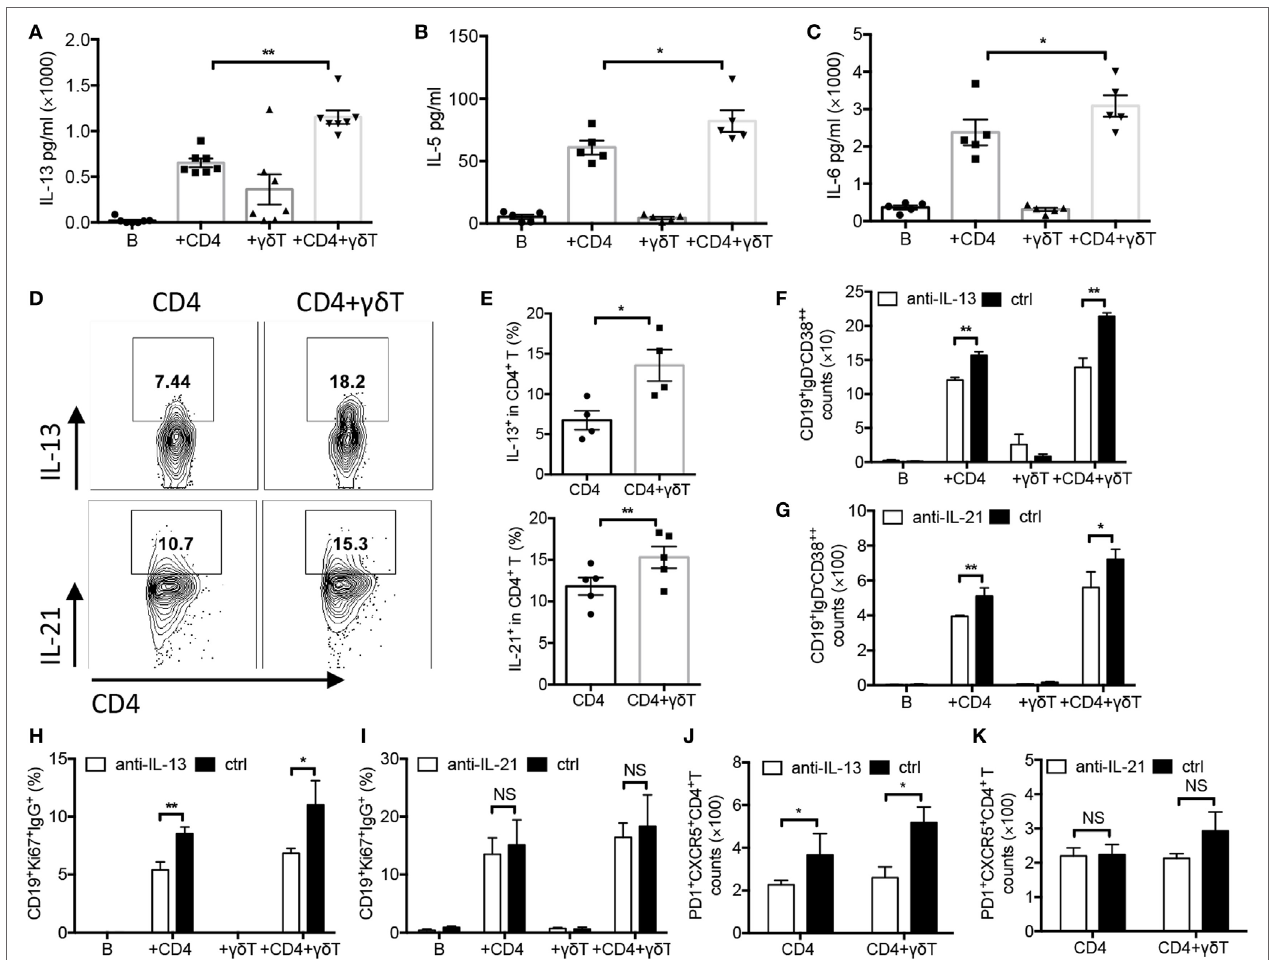
FigUre 5 | V γ 9V δ 2-T cells increased productions of IL-13, IL-5, IL-6, and IL-21. Naïve CD4 T cells were cultured with UV-H9N2 virus-pulsed dendritic cells for 4–5 days, then, the activated CD4 T cells were cultured with CD19 + B cells from same donor with or without V γ 9V δ 2-T cells for another 7–10 days. Supernatant in different groups were collected on day 5 and were detected by Cytometric Bead Array. Data showed the productions of IL-13 (a) , IL-5 (B) , and IL-6 (c) . (D,e) Intracellular IL-13 and IL-21 in CD4 T cells were detected on day 5 by stimulating cells with PMA, inomycin, and BFA within the last 6 h. FACS data represent four to six independent experiments. (F–K) IL-13 neutralizing antibody or IL-21 receptor Fc fusion protein and their controls were added into each group, the number of CD19 + IgD − CD38 ++ plasma cells (F,g) , the frequency of CD19 + Ki67 + IgG + B cells (h,i) , and the number of PD1 + CXCR5 + CD4 + T follicular helper cells (J,K) were detected on days 6, 3, and 5, respectively. Each dot means one donor. The data shown are the mean ± SEM. * p < 0.05; ** p < 0.01. NS, no significant